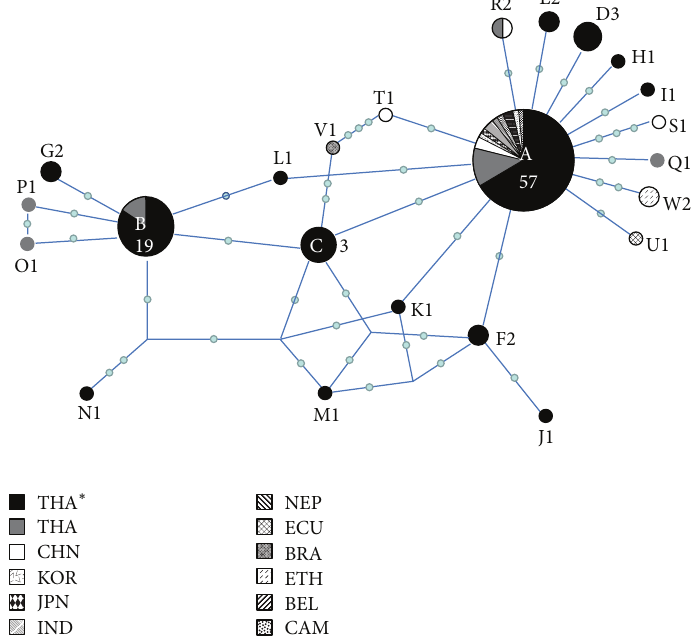
Figure 3: A median-joining network of T. saginata from Thailand (THA ∗ , 𝑛 = 73 ) and other 11 countries ( 𝑛 = 33 ). Haplotype codes (A-W are shown inside/adjacent to the circles. The size of circle denotes that a haplotype is proportional to the number of isolates of each haplotype shown inside/adjacent to the circle. Small circles indicate the number of nucleotide substitutions. THA: Thailand, CHN: China, KOR: